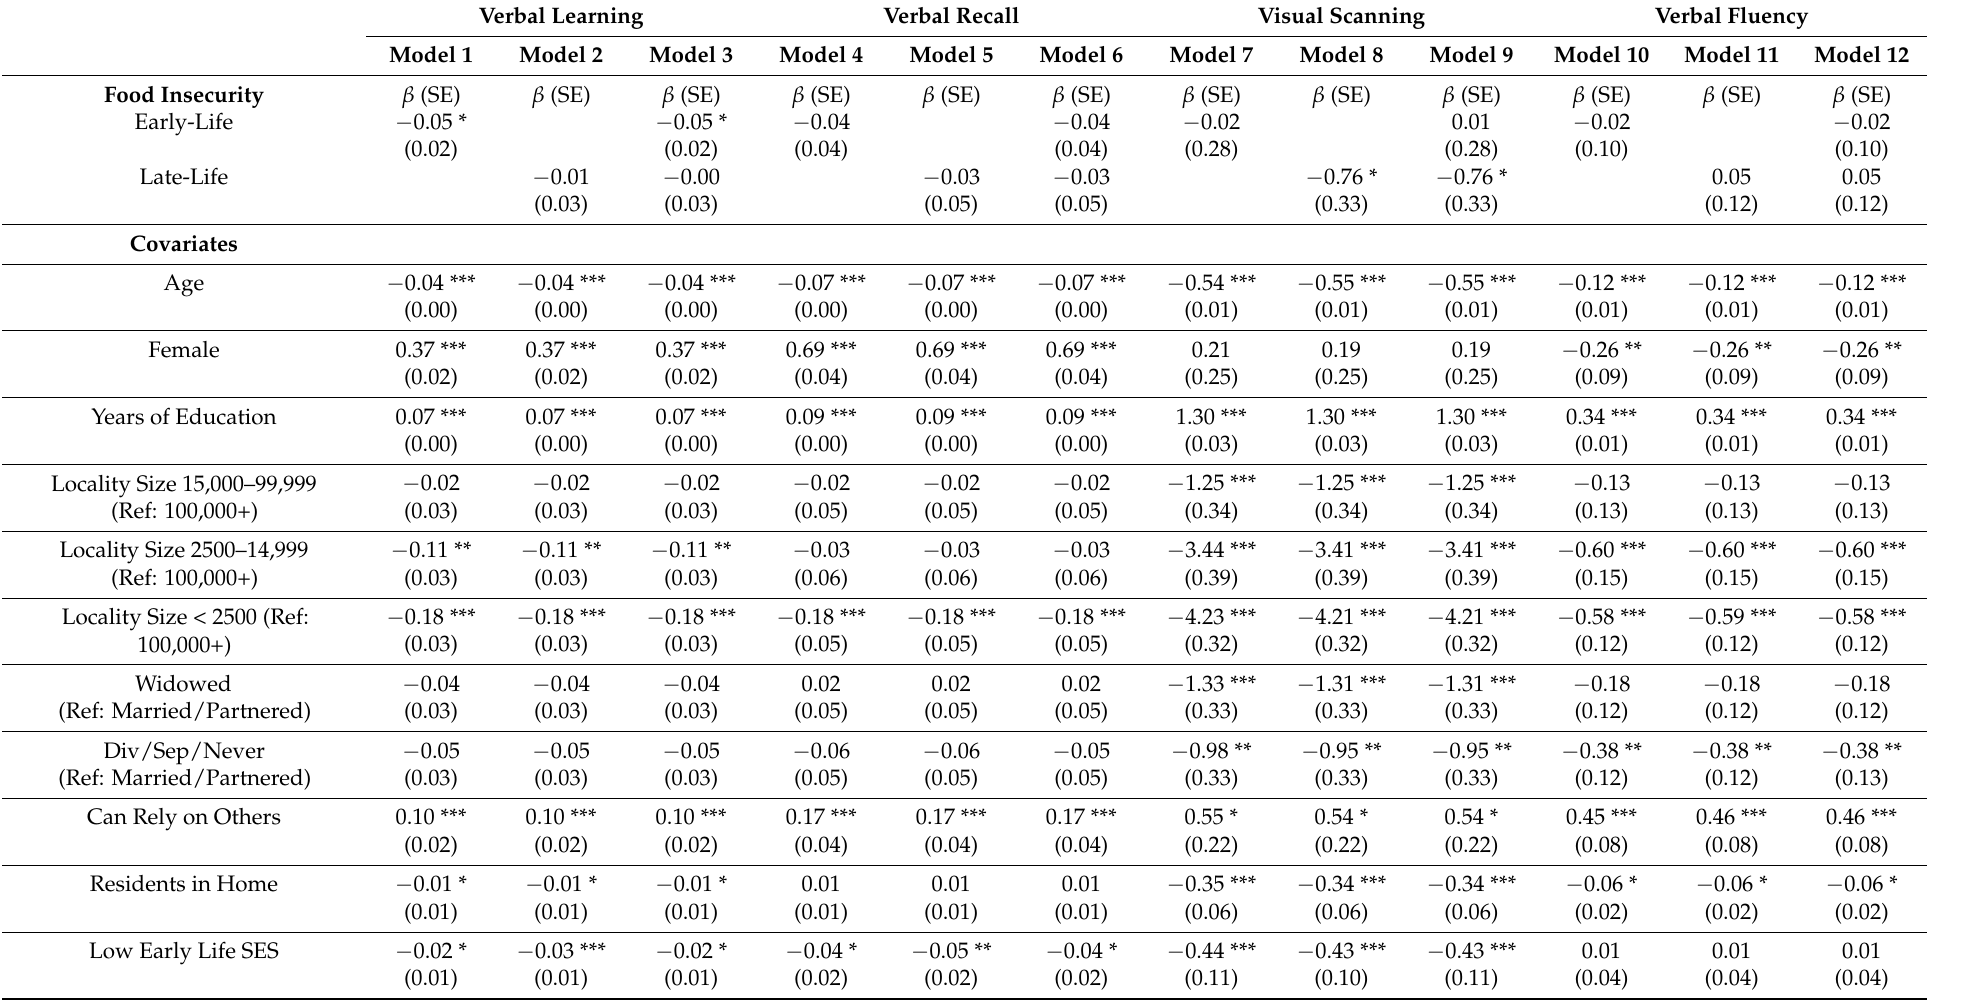
Table 2. Ordinary Least Squares Regressions of Cognitive Domains among Older Mexican